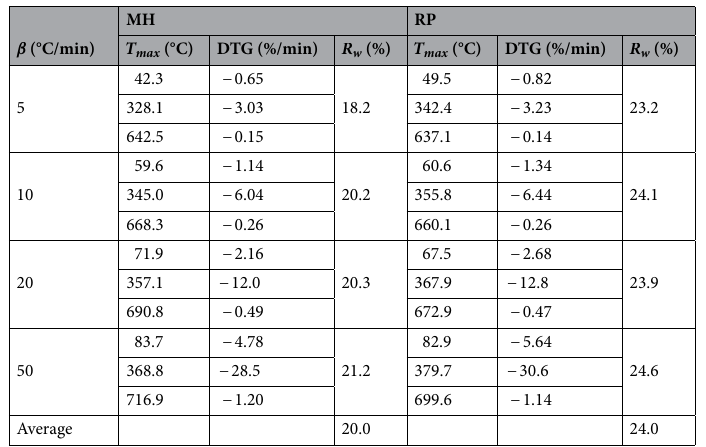
Table 2. Heating rate, and DTG peak temperatures of MH and RP decomposition in N 2 pyrolytic environment. β heating rate, T max maximum peak temperature, R w residual